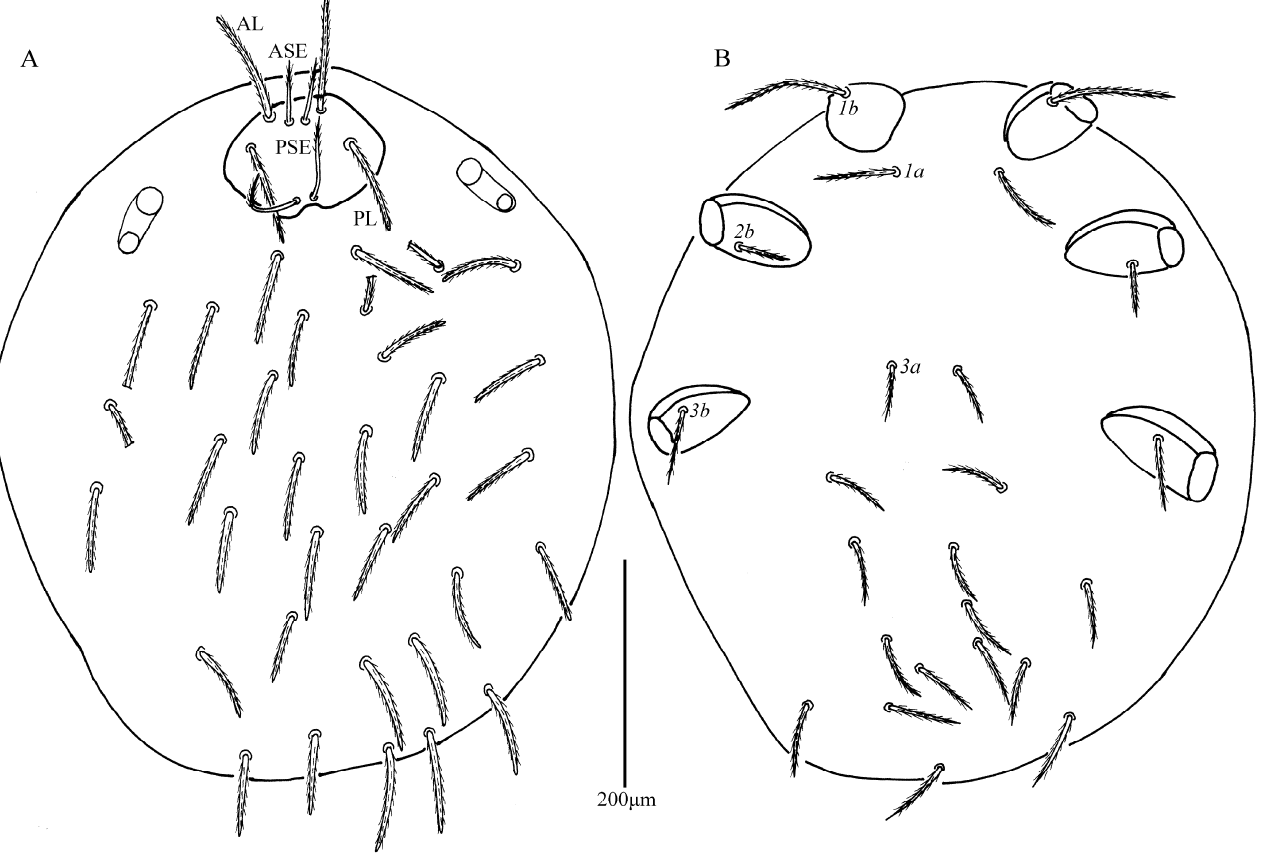
Figure 5. Erythraeus ( Erythraeus ) kunyuensis sp. nov. , larva. ( A ). Dorsal view of idiosoma. ( B ). Ventral view of idiosoma.